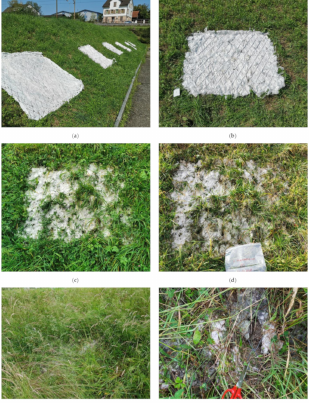
Figure 3. Photographs of the installed prototypes, ( a ) installed prototype 1–6, ( b ) day of installation, ( c ) after 11 weeks, ( d ) after 22 weeks, ( e ) after 35 weeks ( f ) close-up view after 35 weeks.